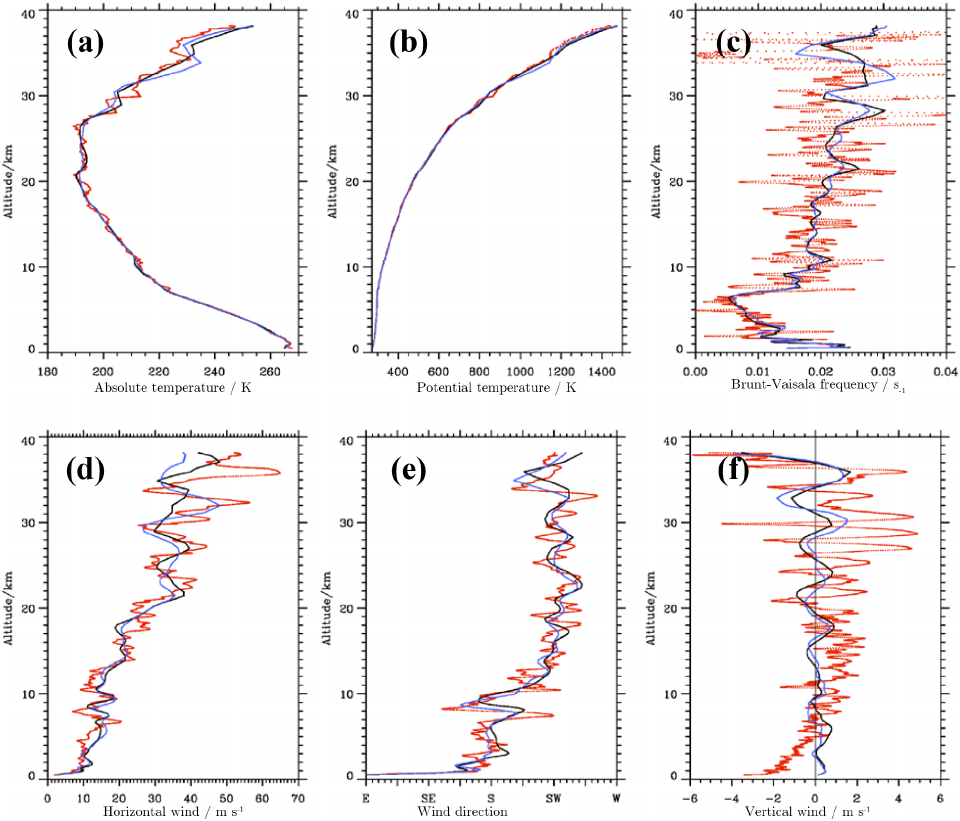
Figure 3. Vertical profiles of the absolute temperature (a) , potential temperature (b) , buoyancy frequency (c) , horizontal wind (d) , wind direction (e) , and vertical wind (f) . Red dots: radiosonde observations from the 30 January 2016 09:08UTC ascent. Solid lines: ECMWF IFS operational HRES forecasts interpolated in space and time on the balloon trajectory from cycle 41r1 (black) and 41r2 (blue). The ECMWF vertical winds are multiplied by a factor of 10. The vertical winds from the balloon sounding are calculated as the difference of the local ascent rate and a mean ascent rate of 6.1ms − 1 determined as an integral value over the whole